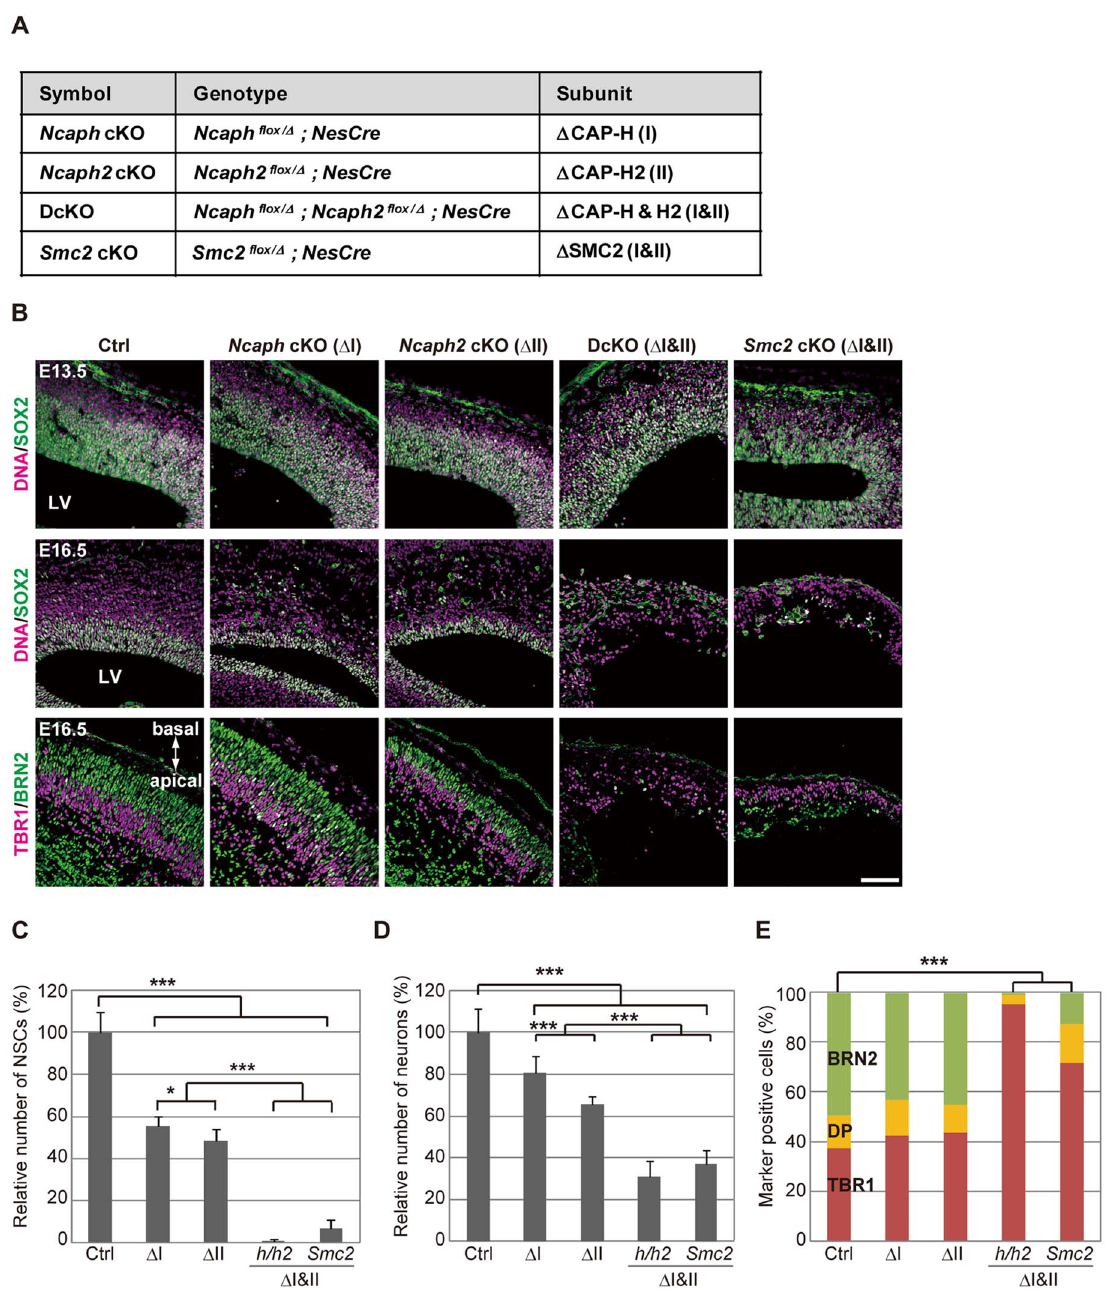
Figure 2. Condensins I and II are both required for proper development of the cerebral cortex. ( A ) Genotypes of mice used in the current study. The heterozygotes of Ncaph or Ncaph2 mutants in the NesCre background were used as a control (Ctrl). ( B ) Frozen sections of embryonic brains from cKO mice at E13.5 or E16.5 were immunolabeled with cell-type specific markers: SOX2 for NSCs; TBR1 for deep-layer neurons; BRN2 for upper-layer neurons. DNA was counterstained with Hoechst in the upper and middle panels. The data shown are from a single representative experiment out of three repeats. Sections from at least two different embryos of each genotype were analyzed. Bar, 100 m m. ( C ) The numbers of SOX2-positive cells were measured in the dorsal area of cortices in control and cKO mice. Data were obtained from four independent sections from two different embryos and normalized to the mean number of NSCs in control mice as 100%. Bars indicate the mean and SD. * P , 0.05, *** P , 0.001 ( t -test with a Holm correction for multiple comparisons). ( D ) The numbers of cells present in the CP were measured. Data were obtained and analyzed as in ( C ). ( E ) The ratios of TBR1-positive, BRN2-positive, and double-positive (DP) cells were measured in the CP at E16.5. Data were obtained from two different embryos (at least 600 neurons scored). *** P , 0.001 (Chi-squared test). reported that RNAi-mediated depletion of Smc2 induces meta- mice; . 40 cells were scored per experiment): fuzzy masses of chromatin were observed, in which individual chromosomes were phase arrest in mouse embryonic stem cells [28], such arrest was no longer discernible from each other. Although it had been not observed in NSCs in DcKO and Smc2 cKO mice. The cells